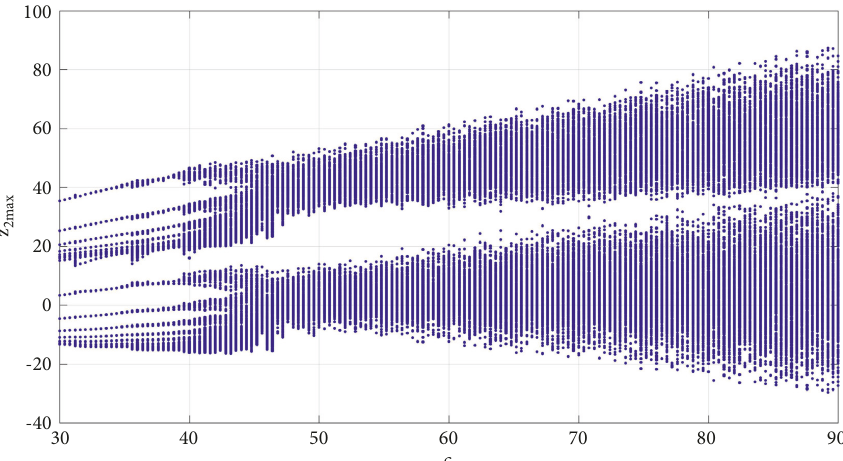
Figure 14: Bifurcation diagram for the model (1) when c varies in [ 30 , 90 ] and ( a,b, d ) � ( 25 , 8 , 6 ) .